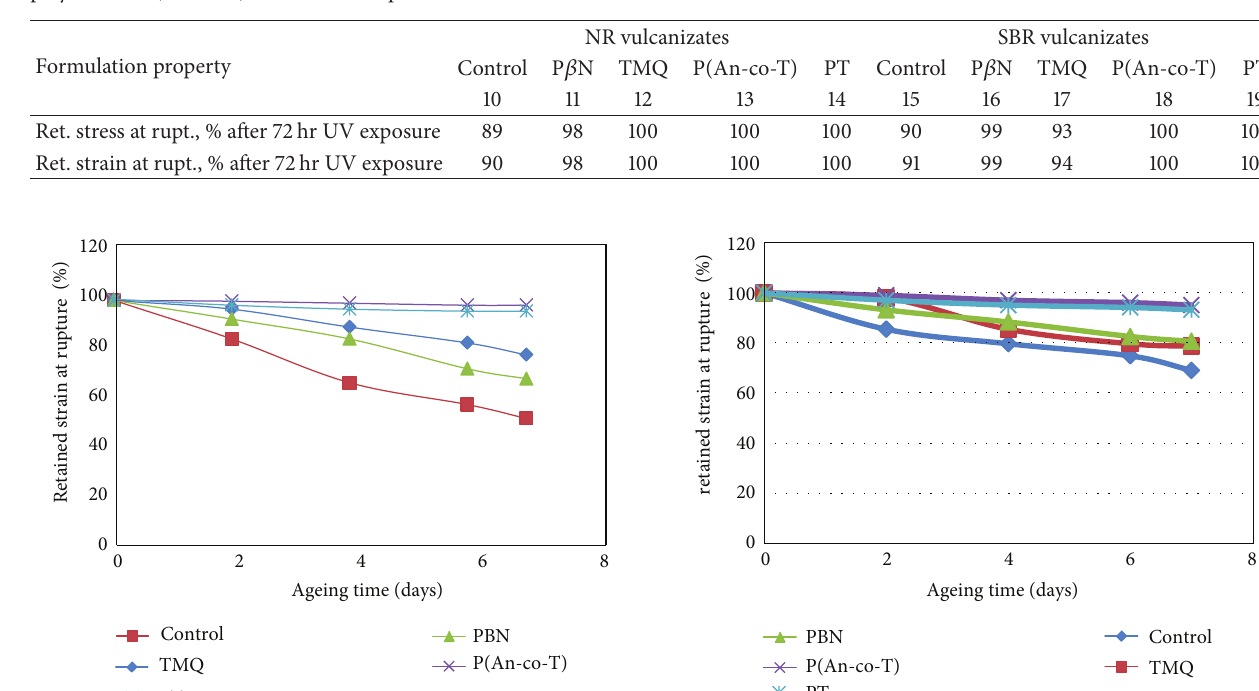
Figure 8: Retained strain at rupture versus ageing time for NR vulcanizates.